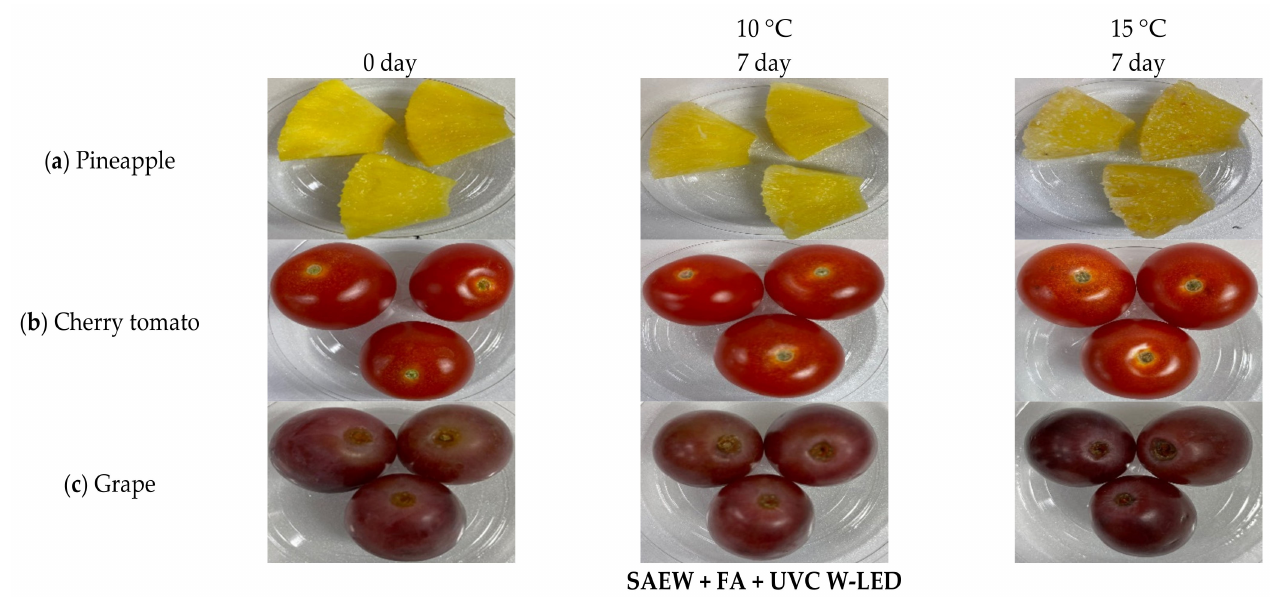
Figure 8. Changes in the overall visual quality of pineapples, cherry tomatoes, and grapes treated with a combination of SAEW + FA and UVC W-LED after storage for 7 days at 10, 15 ◦ C. SAEW, slightly acidic electrolyzed water; FA, fumaric acid; UVC W-LED, ultravioletC waterproof light-emitting